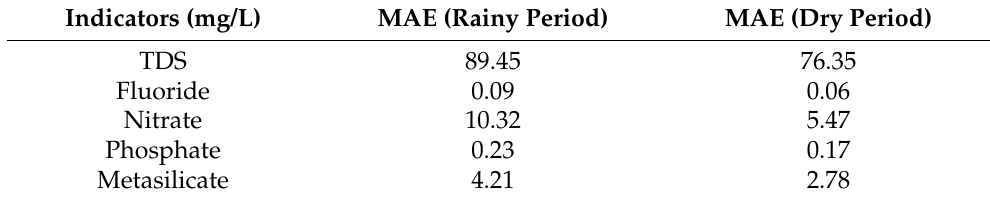
Table 6. MAE of prediction results based on